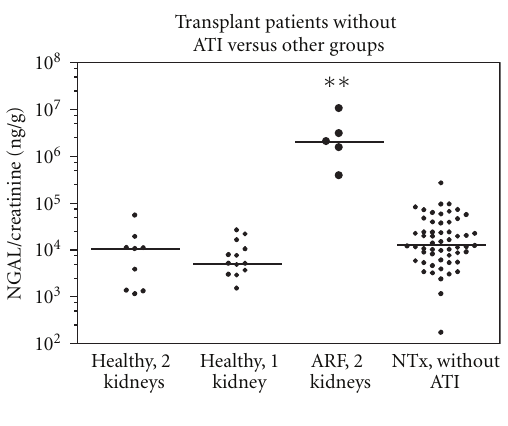
Figure 1: Urinary NGAL/creatinine ratios in transplanted patients versus other groups. Shown are the urinary NGAL/creatinine levels of the two control groups (healthy individuals with 2 ( n = 9) or 1 kidney ( n = 13)) versus ICU patients with acute renal failure (ARF, 2 kidney ( n = 5)) and transplanted patients without ATI ( n = 56). Patients with acute renal failure had significantly higher urinary NGAL levels compared to the other groups ( P < 0 .